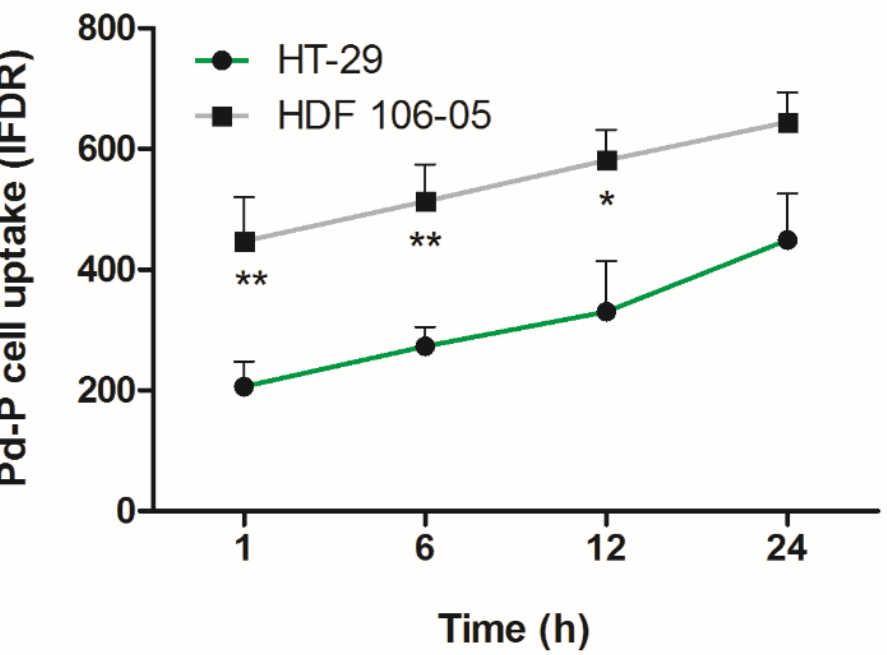
Figure 1. Pd-P cellular uptake in HT-29 and HDF 105-06 cells over time. HT-29 and HDF 105-06 cells were incubated for 1, 6, 12 and 24 h with 500 µ M Pd-P, and stained with DAPI. Sample fluorescence intensity was determined using a fluorescent plate reader and expressed as intensity of fluorescence DAPI related (IFDR). Statistically significant difference versus HT-29 cells: * p < 0.05, ** p < 0.01. Furthermore, to establish the cellular localization of the metal-porphyrin complex, a confocal fluorescence analysis of 500 µ M P-Pd in HT-29 and HDF 106-05 cells was performed after 24 h of incubation. As shown in Figure 2a, Pd-P principally showed a cytoplasmic distribution. In particular, in HDF 106-05 cells, more fluorescent aggregates were visible at the cytoplasmic level and throughout the cellular body, whereas in HT-29 cells, more fluorescent aggregates were visible in the perinuclear regions. Finally, from confocal fluorescence analysis, we were also able to confirm that the concentration of the Pd-P complex in both cell lines, after 24 h incubation of the Pd-P complex, was statistically significantly different compared to the basal autofluorescence of untreated cells by CTCF quantification (Figure